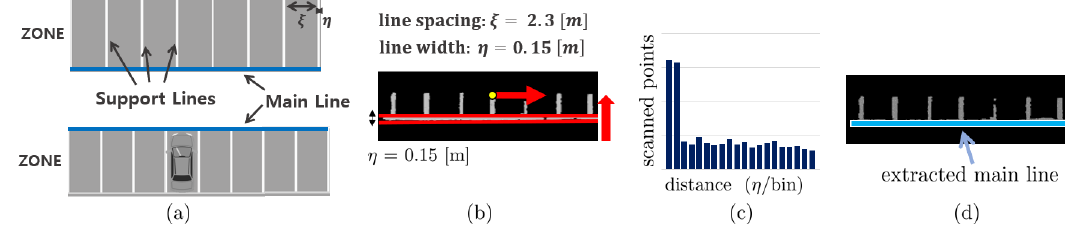
Figure 8. ( a ) Graphical image of parking spaces. Both the main line and support line are defined arbitrarily. The thickness of the support line is already specified as η = 0.15 m, and the size of the parking space is specified as ξ = 2.3 m in our parking environment. The parking line specification is determined by the Korean Parking Act and can be changed according to the country or region. ( b ) Scan the data distribution of the main line. ( c ) The histogram shows the data distribution of the main line. The bin of the main line tends to be longer than those of the other locations. ( d ) The main line is extracted by selecting the maximum bin in the